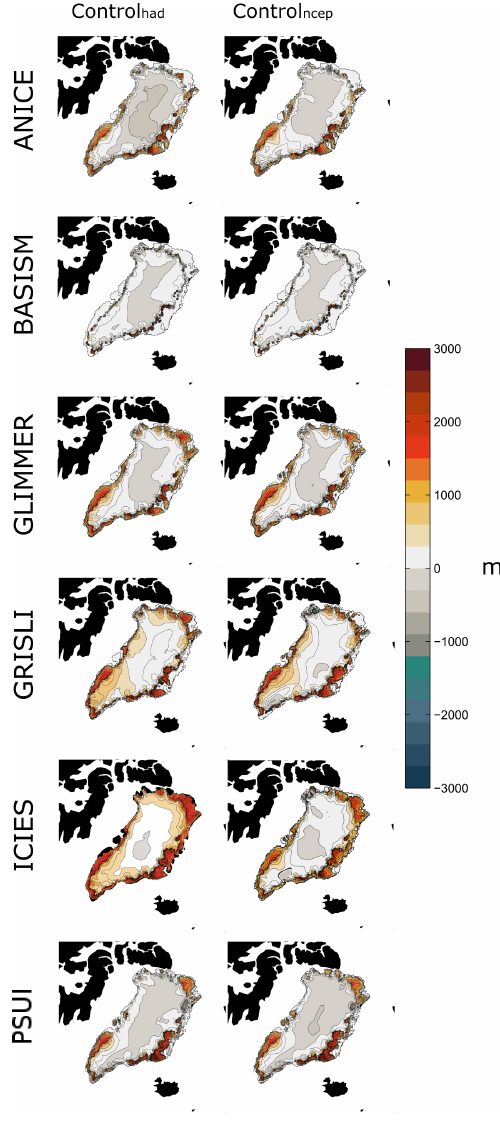
Figure 2. Ice sheet surface elevation [m] anomalies for Control had (left panels) and Control ncep (right panels) relative to observed present-day Greenland Ice Sheet calculations from Bamber et al. (2001a) for individual ice sheet models ANICE, BASISM, Glim- mer, GRISLI, IcIES, and PSUI (from top to bottom). Modern-day coastlines are used, and the ocean is masked out for plotting the